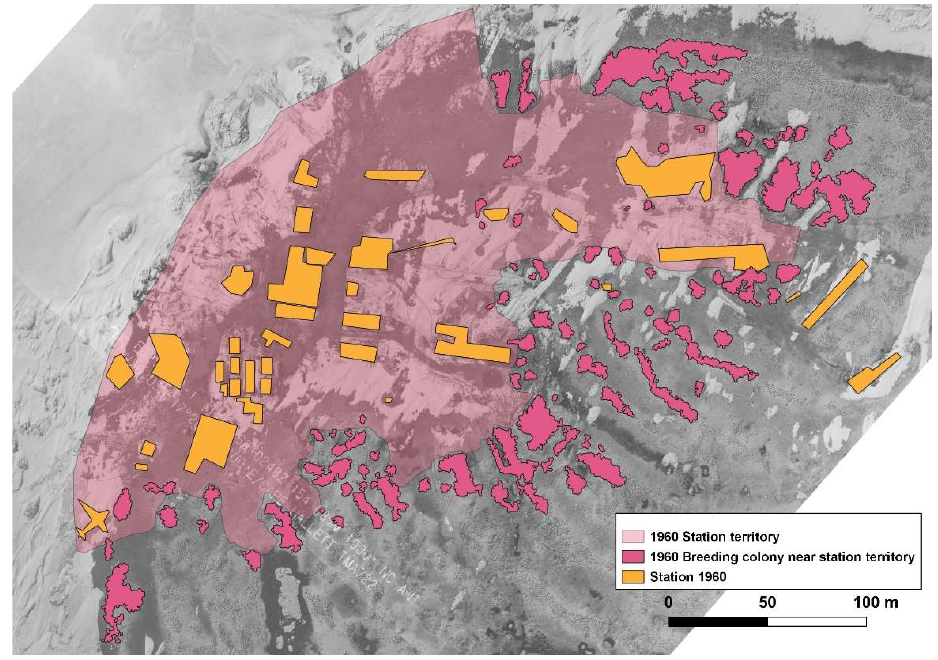
Figure 3. Cape Hallett station penguin colony status and the nearby station territory in 1960.